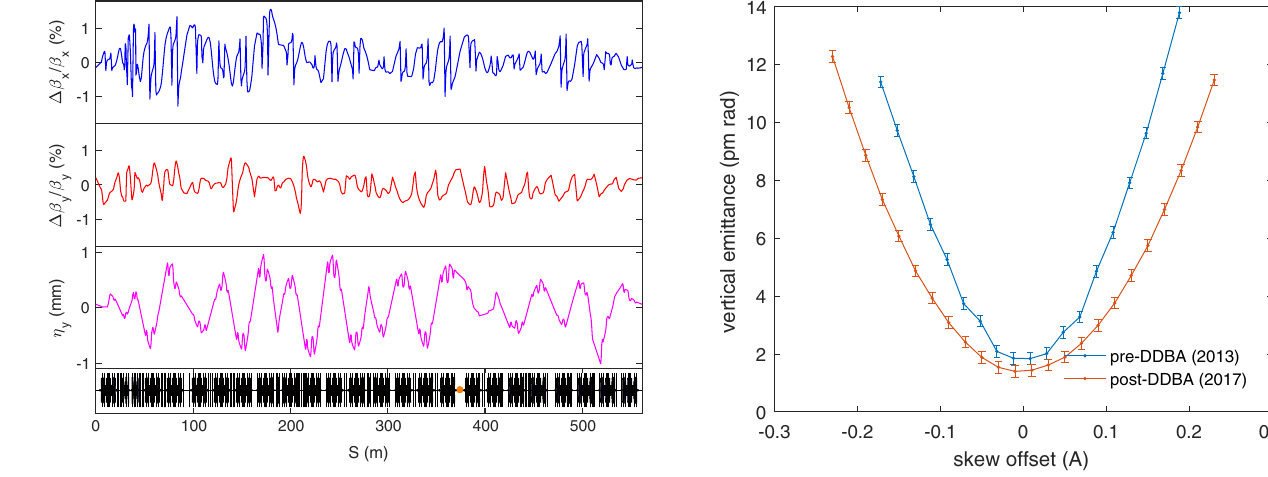
FIG. 2. Measured optics distortions after correction. FIG. 3. Vertical emittance as a function of skew quadrupole offset before and after the installation of the DDBA cell. The error bars for the measured data are estimates based on imprecise knowledge of the pinhole camera point-source functions and Twiss parameters in the